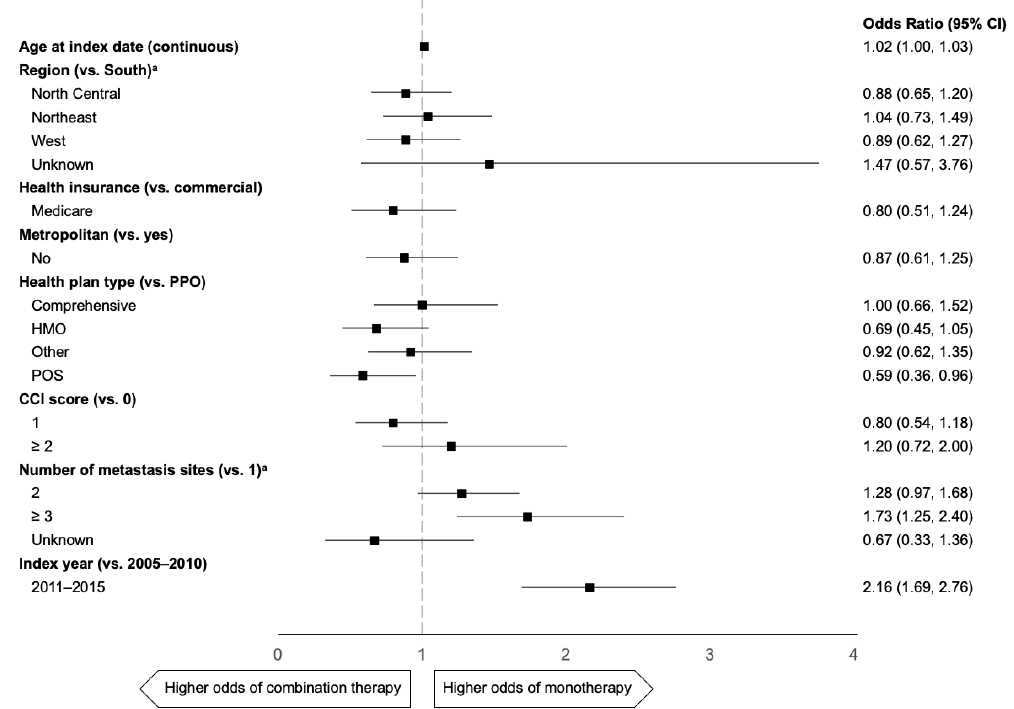
Figure 2. Predictors of taxane monotherapy versus combination therapy in 1L mTNBC. 1L: first line, CCI: Charlson Comorbidity Index, HMO: health maintenance organization, mTNBC: metastatic triple-negative breast cancer, POS: point of service, PPO: preferred provider organization. a Unknown categories are not shown because of unstable estimates from small sample sizes.